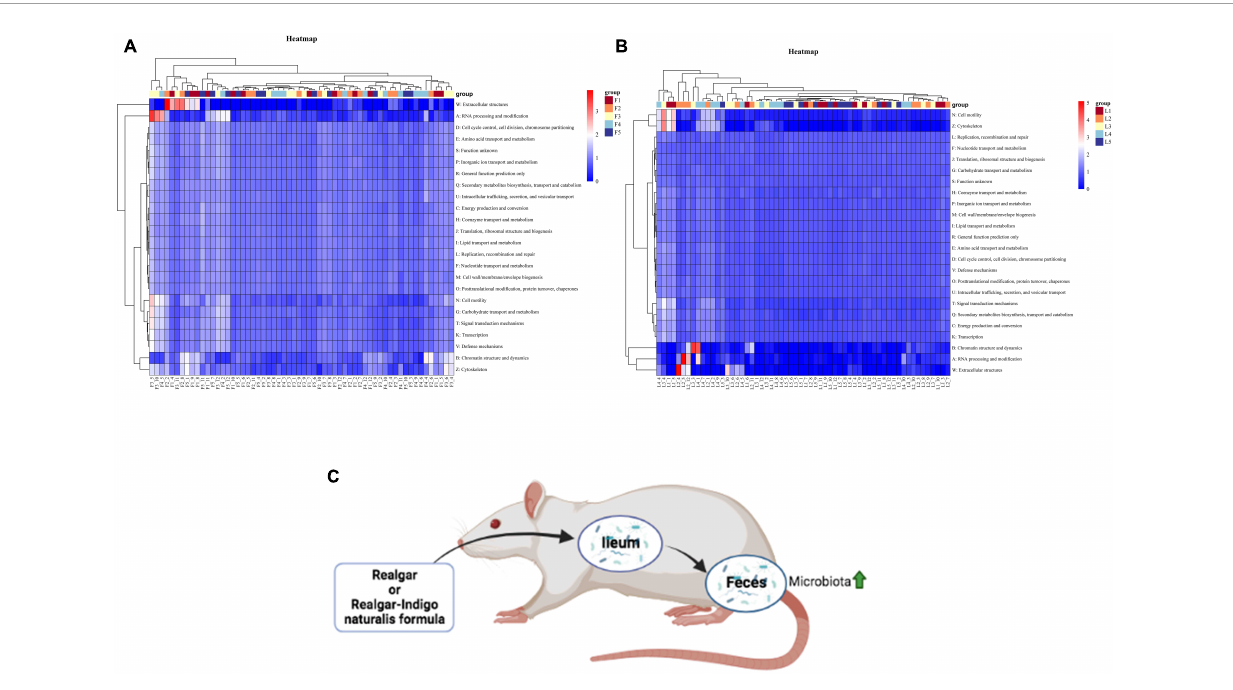
FIGURE7 Heatmap of predicted functions based on COG analysis with PICRUSt. (A) Bacterial functional categories annotated by PICRUSt in feces. (B) Bacterial functional categories annotated by PICRUSt in ileum. [There are 95% probabilities of predicting the functions of gut microbiota ( p < 0.05).] (C) The summarization of realgar and RIF effects on